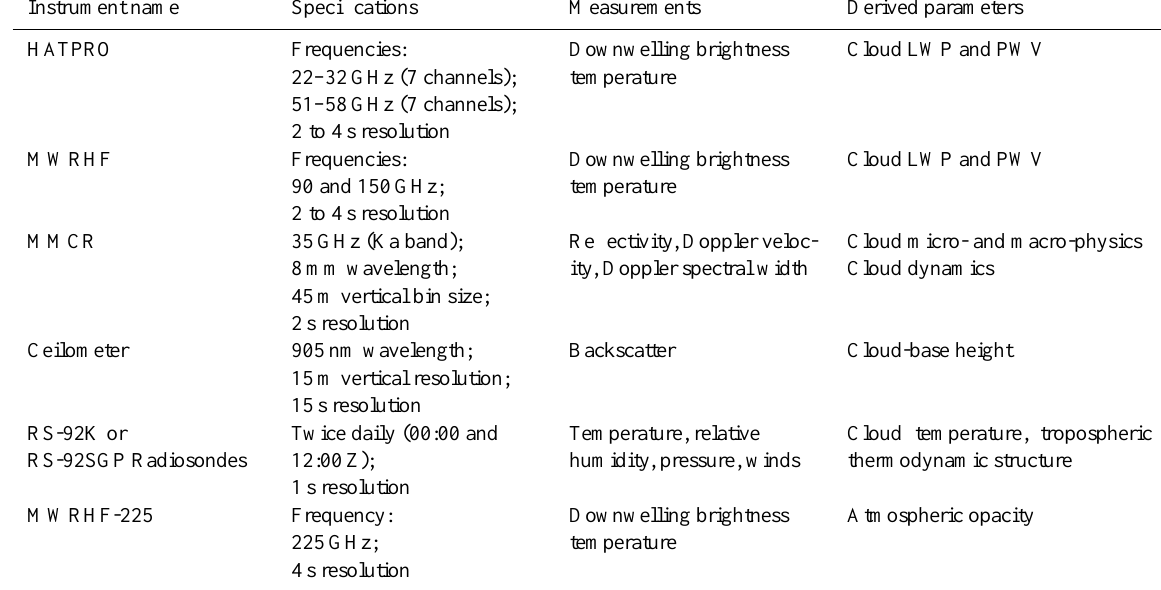
Table 1. Sub-group of ICECAPS suite instruments used in this study (modified from Table 1 in Shupe et al.,